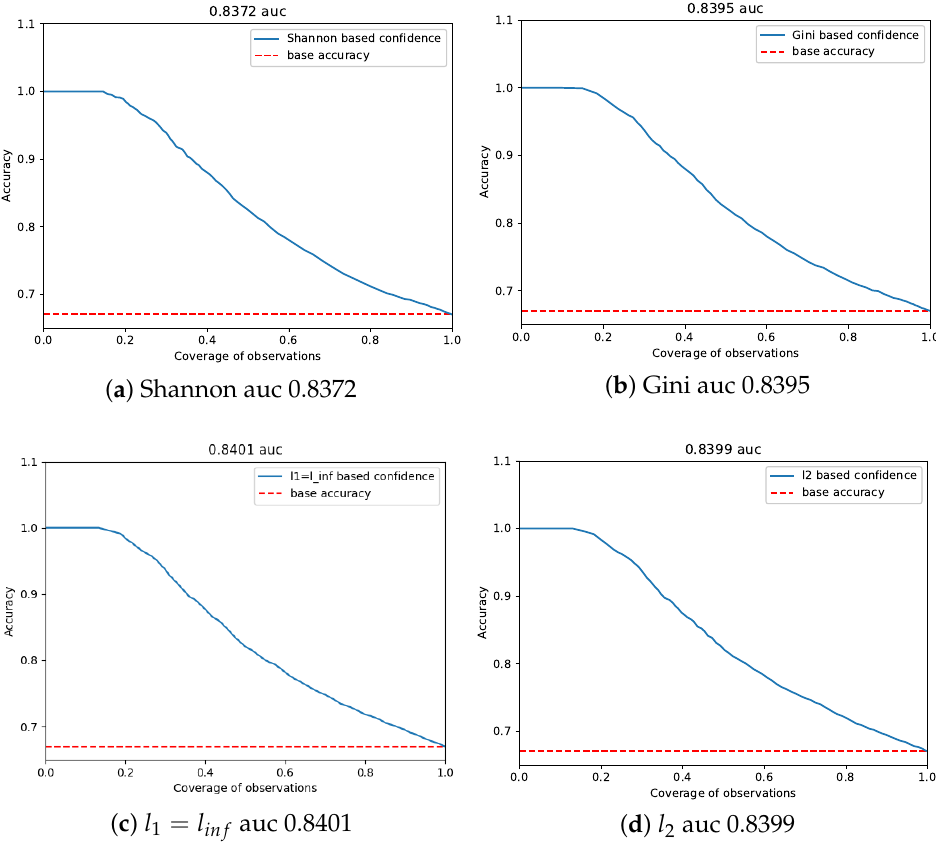
Figure 5. Confidence threshold curves comparison. Table 5. Comparison of threshold area under the curve with different confidence